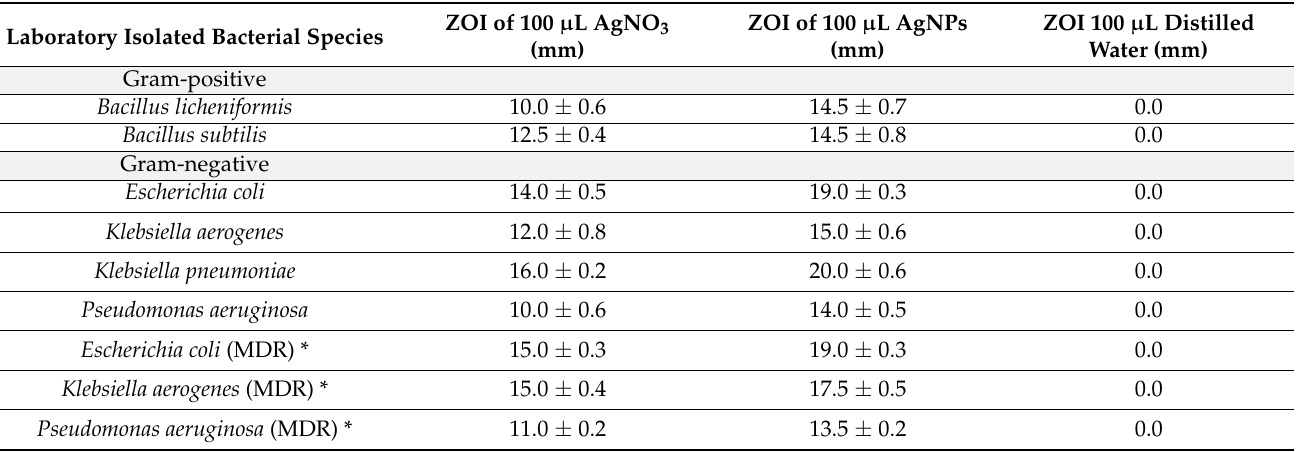
Table 4. Antibacterial activity of colloidal 1mM AgNPs against laboratory pathogens and MDR